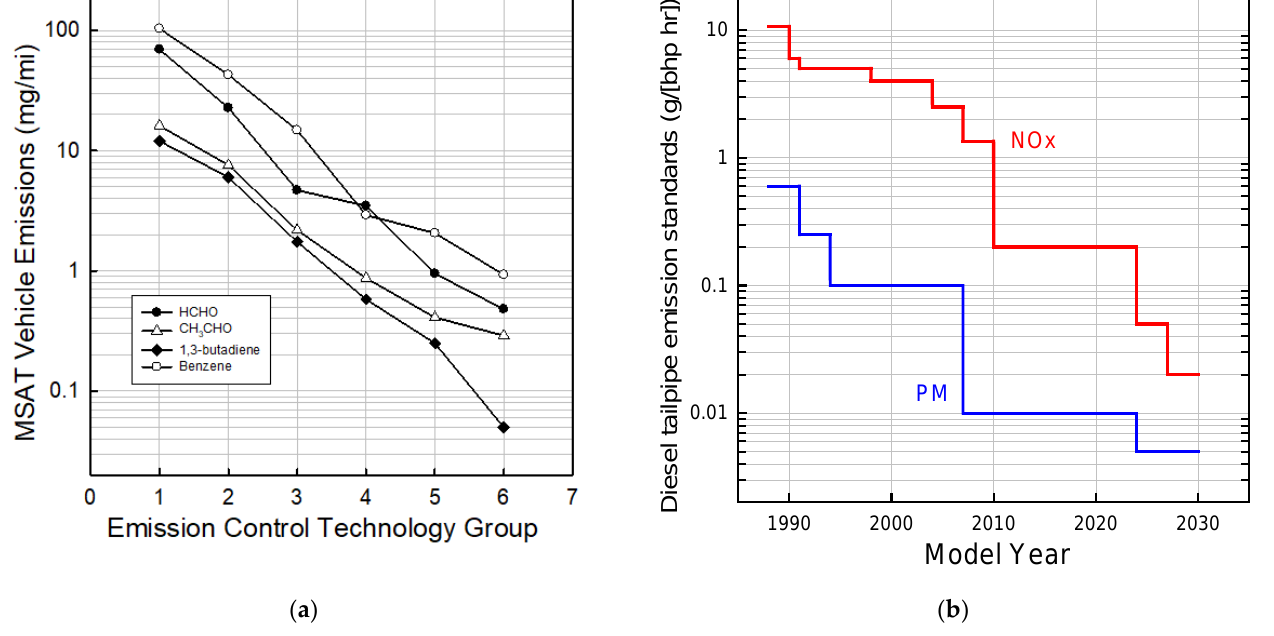
Figure 3. ( a ) Emissions of formaldehyde, acetaldehyde, 1,3-butadiene, and benzene from gasoline light-duty vehicles as increasingly sophisticated emission control technology was added over the vehicle model years 1970–2000. The technology groups are: (1) non-catalyst, (2) oxidation catalyst, (3) three-way catalysts, (4) transitional—low emission vehicles, (5) low emission (LEVs), and (6) ultra-low emission vehicles (ULEVs). ( b ) Evolution of emissions standards for NO x and PM for heavy-diesel vehicles (updated from